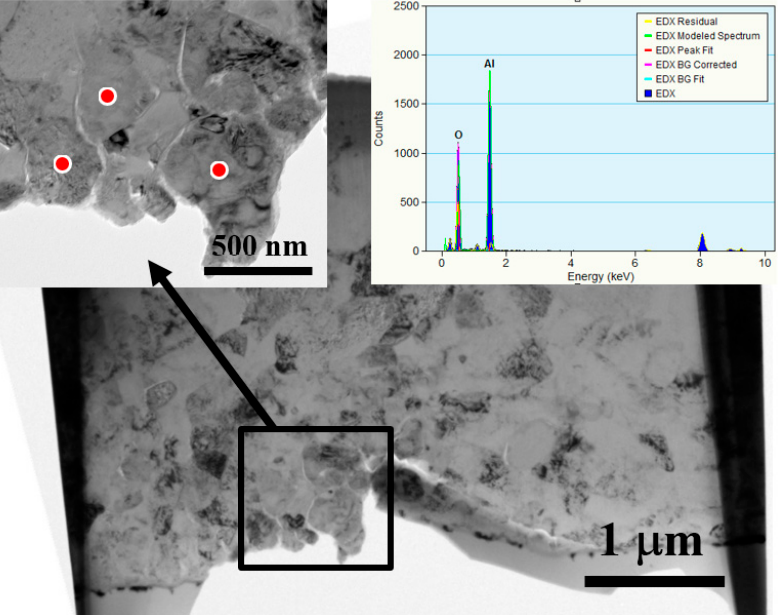
Figure 6. TEM images for the inserted 0.5 μ m Al 2 O 3 particles in the 1050 Al plate, with the EDS spectrum on the top right.